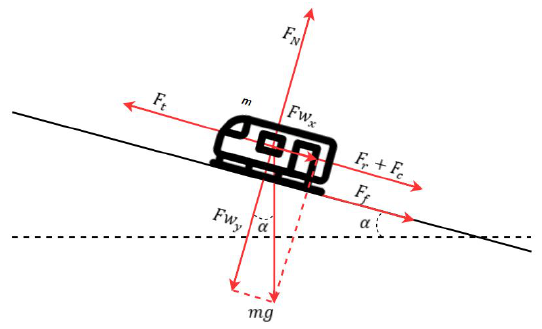
Figure 1. Free-body diagram of a